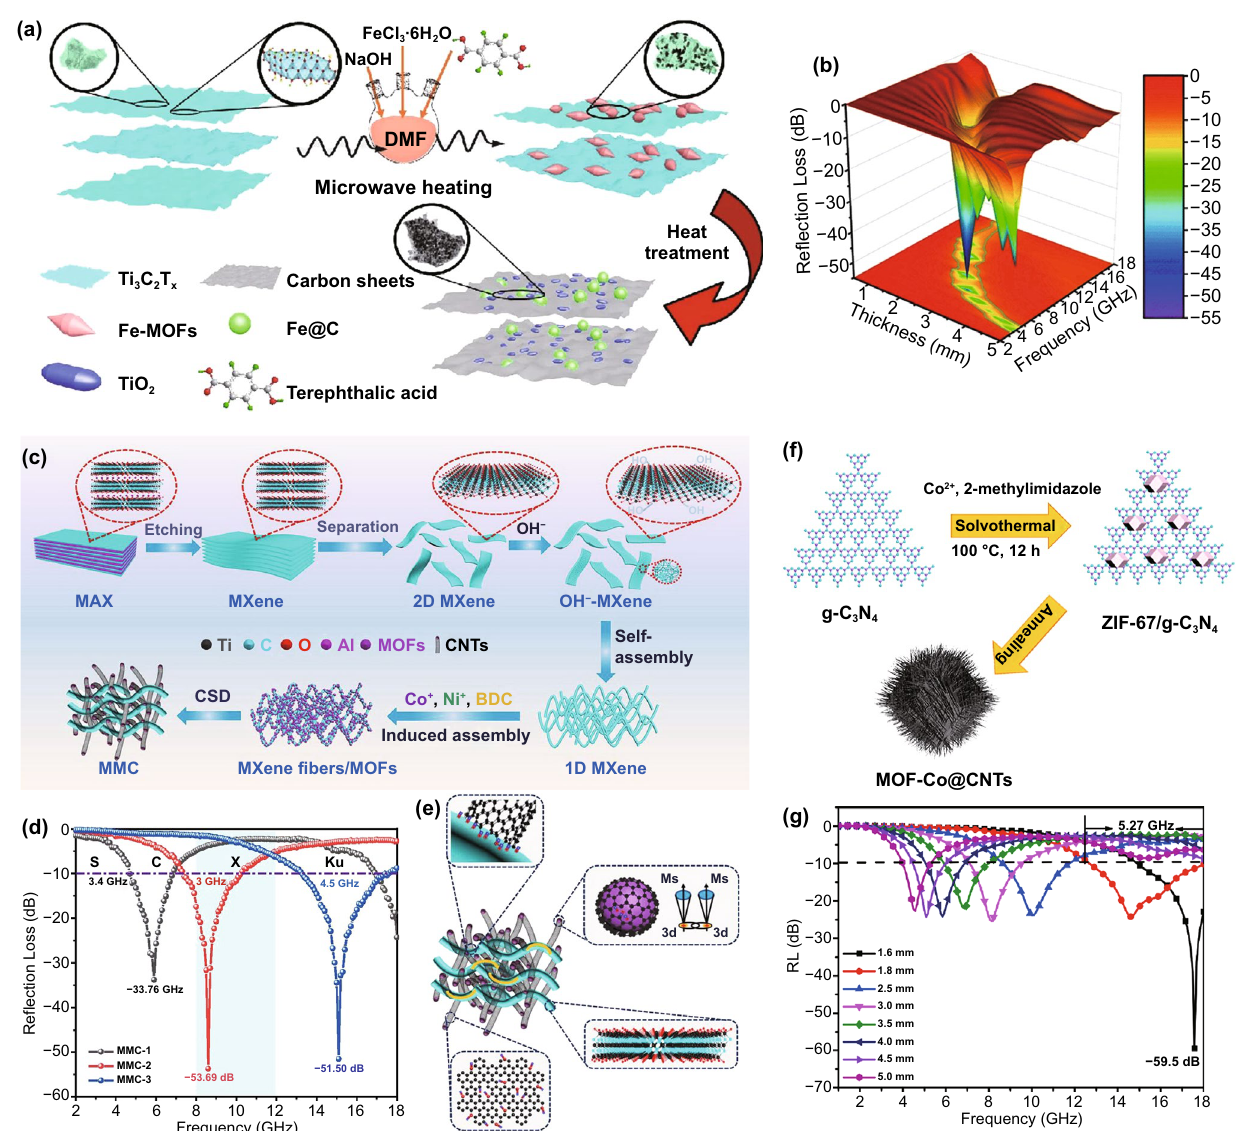
Fig. 16 a Schematic illustration of the synthesis and b 3D RL-f curves of Fe&TiO 2 @C. Reprinted with permission from Ref. [156]. c Sche- matic description for preparation d RL-f curves and e MA mechanism diagram of MXene fibers@MOF-derived CNTs nanocomposites. Reprinted with permission from Ref. [59] f Diagrammatic sketch of the synthesis route and g RL-f curves of ZIF-67/g-C 3 N 4 . Reprinted with permission from Ref.